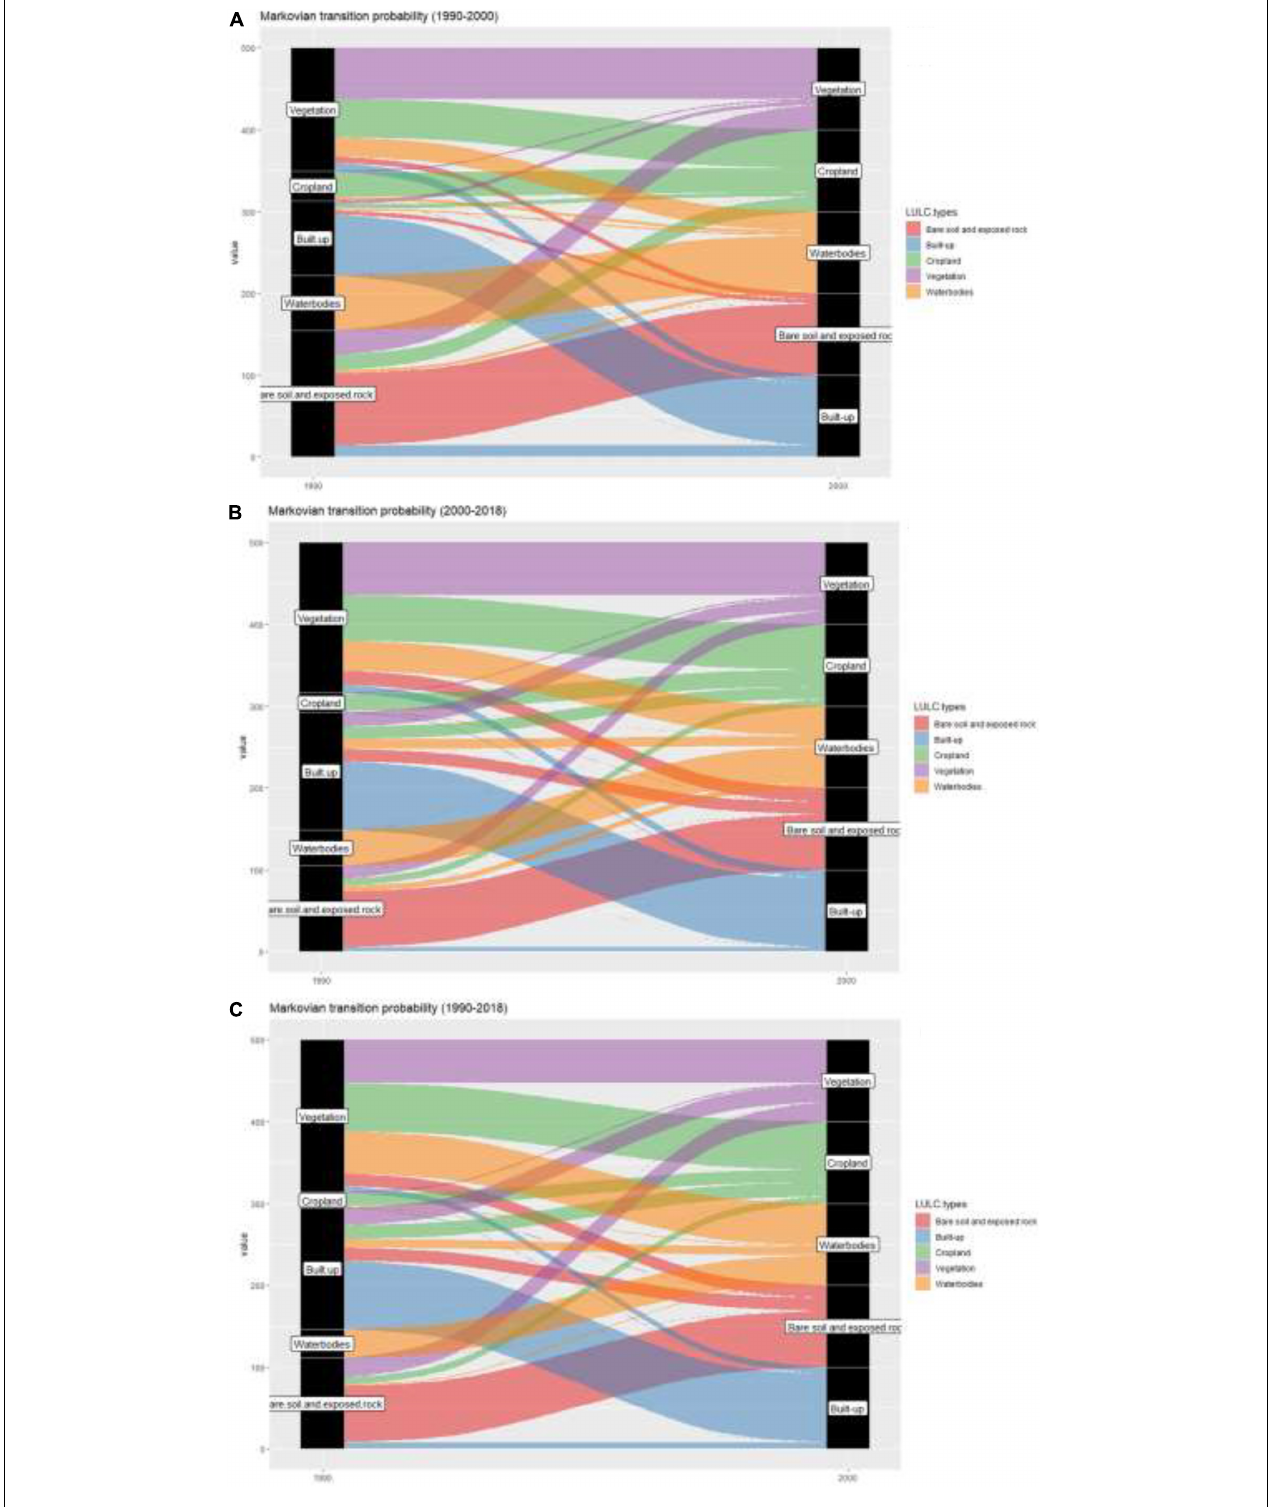
FIGURE 5 | A markovian transitional probability analysis for LULC dynamics for the period of (A) 1990–2000, (B) 2000–2020, and (C) 1990–2020.